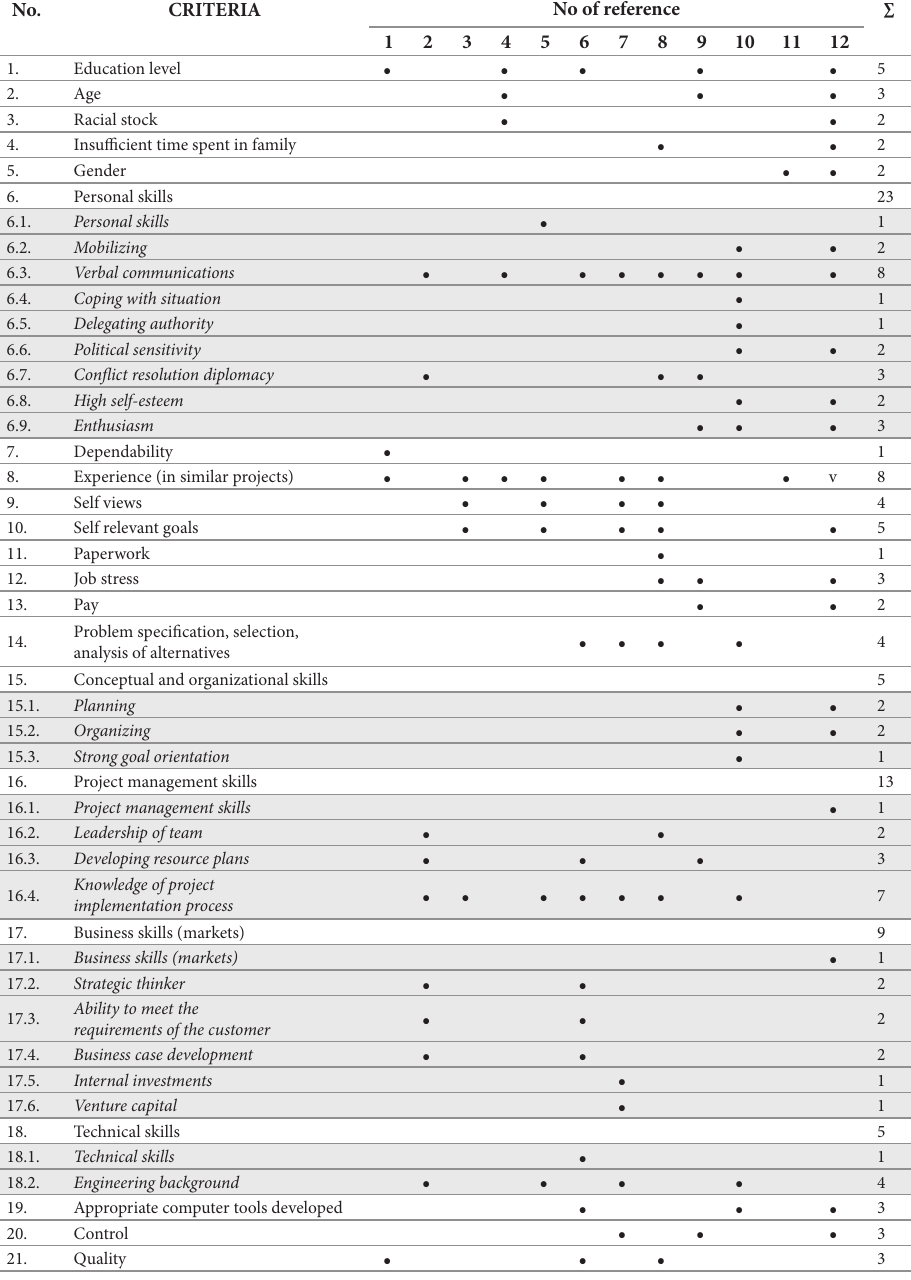
Table 1. A set of the main construction manager selection criteria